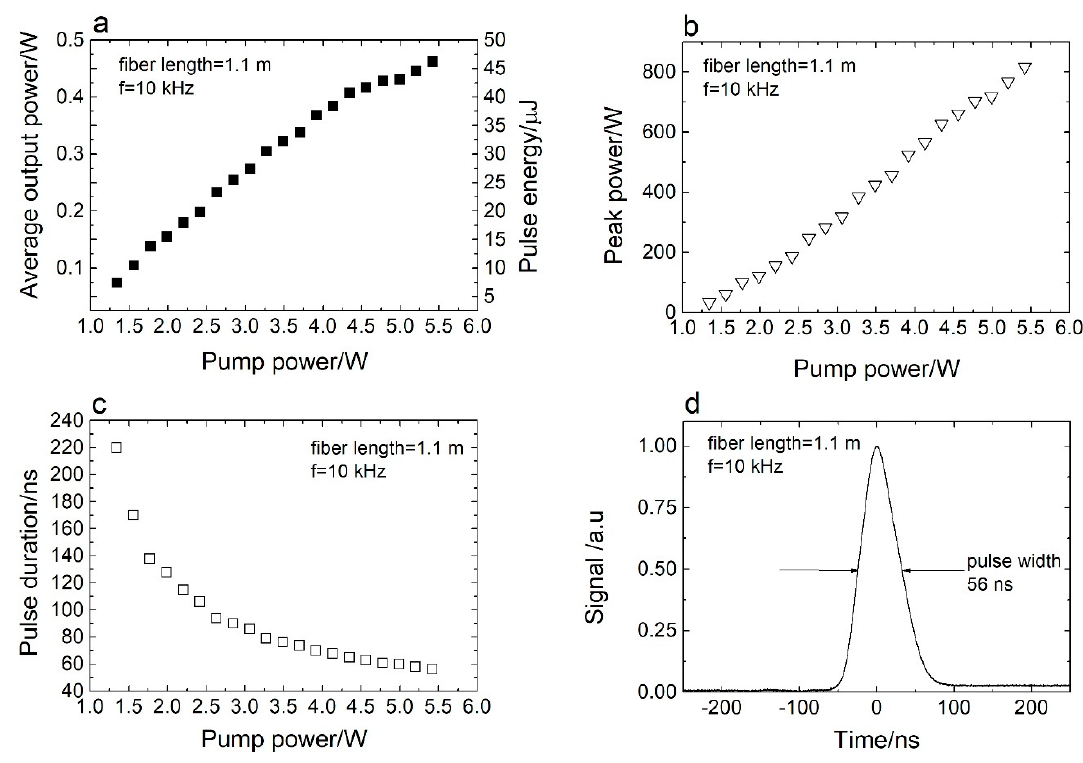
Figure 5. ( a ) Average output power and pulse energy versus pump power. ( b ) Peak power versus pump power. ( c ) Pulse duration versus pump power. ( d ) Pulse shape recorded at 10 kHz. The fiber length used in the experiment was 1.1 m.